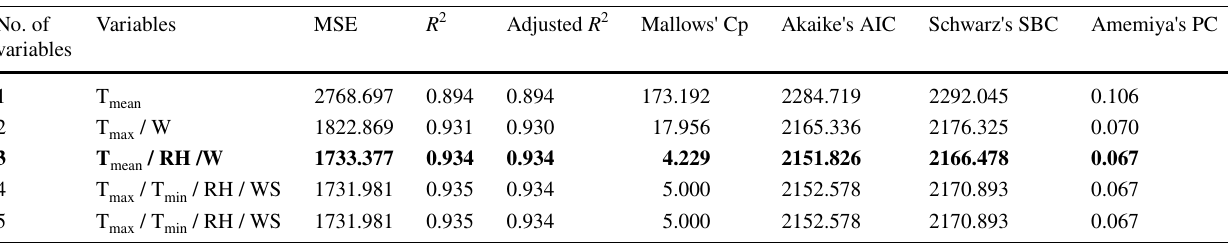
The best model for the selected selection criterion is displayed in green